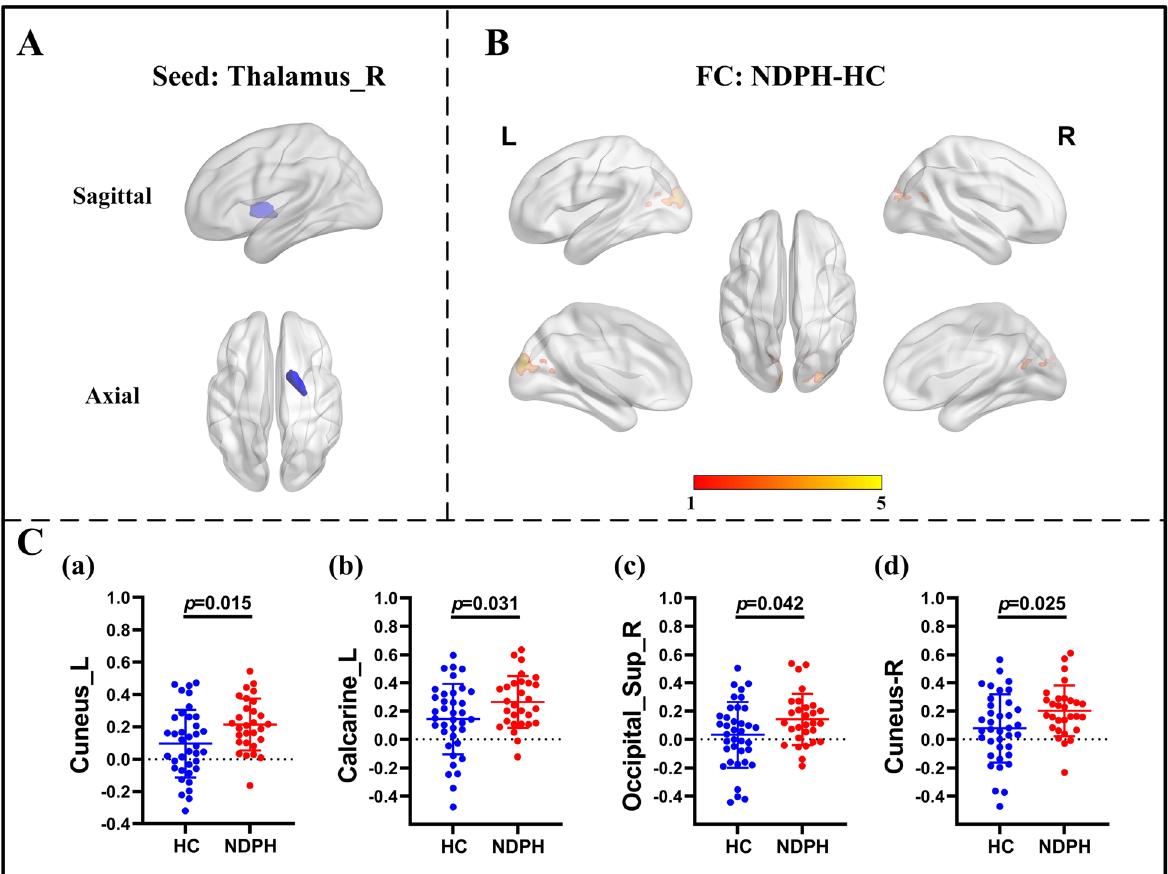
Fig. 5 FC analysis from right thalamus to the whole brain voxels in NDPH and HC groups. A The schematic diagram of the seed (right thalamus). The brain region marked in blue represents the right fusiform gyrus. B The schematic diagram of significant FC differences. Compared with HCs, patients with NDPH showed significantly increased FC between the seed and bilateral cuneus, left calcarine, right superior occipital gyrus. C (a) to (d) represent FC values between the seed and bilateral cuneus, left calcarine, right superior occipital gyrus respectively in HCs and patients with NDPH. Notes: The color bar showed t-values of the two-sample t-tests on FC. Abbreviations: L, left; R, right; Sup, superior; FC, functional connectivity; NDPH, new daily persistent headache; HC, health